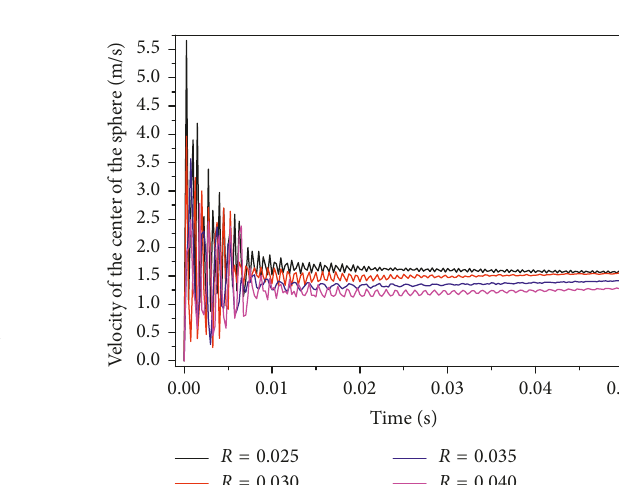
Figure 32: Acceleration of the tail beam.